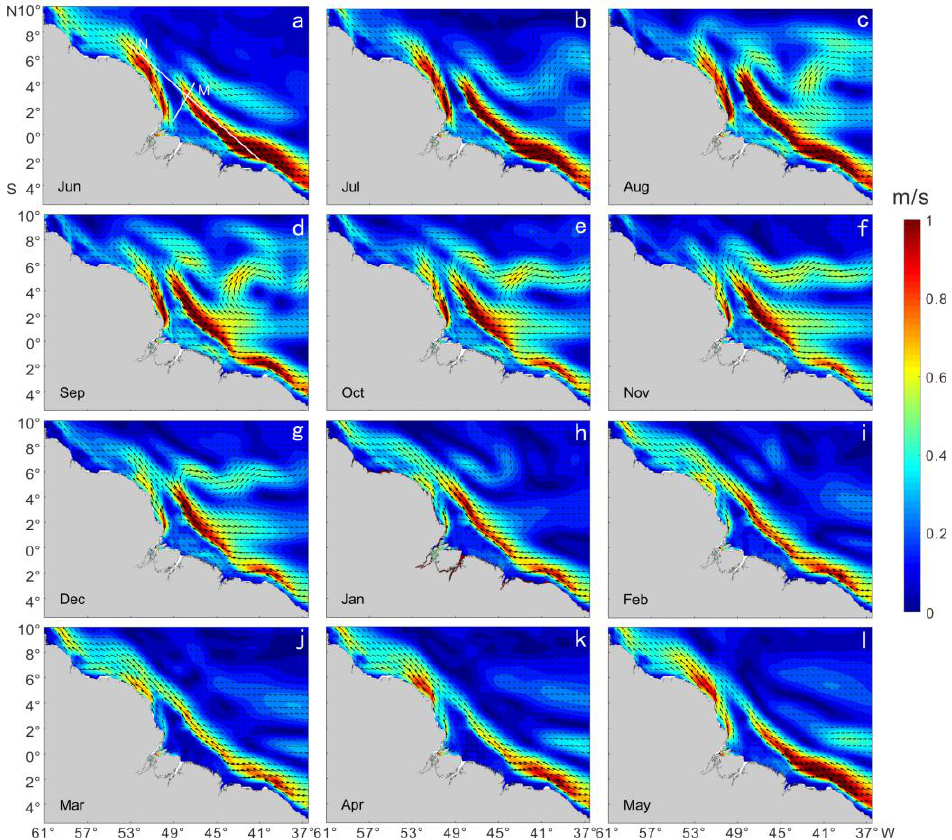
Figure 6. Monthly average flow field over 10 years in the sea area of the Amazon estuary (2008 – 2017). ( a – l ) correspond to the winter period (June – November) and summer period (December – May) in the southern hemisphere, respectively (unit: m/s). Transects M and N are indicated in ( a ).